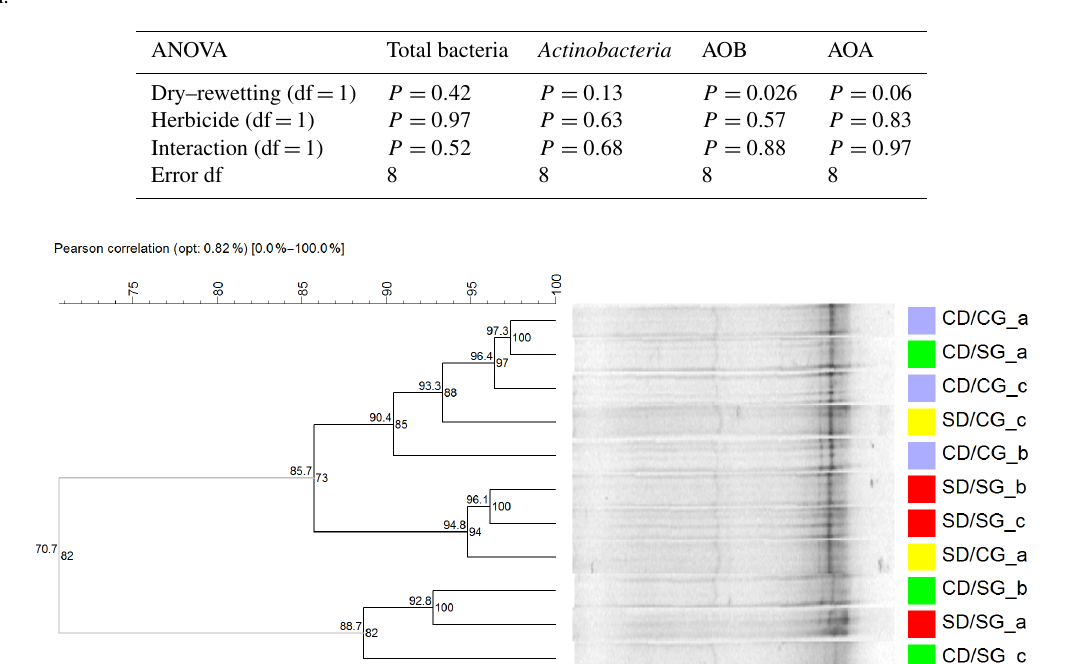
Figure 3. Cluster analysis of DGGE profiles of AOB. The dendrogram was obtained using Pearson–UPGMA analysis of densitometric profiles. Treatments are indicated in different colours. Lower-case letters indicate replicates within treatments. In each node, the left number indicates the similarity value ( r × 100), while the right number is the cophenetic correlation coefficient. Grey branches indicate clusters with 100% internal stability according to the jackknife method, defined at 80% similarity value. SD/SG: no dry–rewetting disturbance/no herbicide; SD/CG: no dry–rewetting disturbance/herbicide; CD/SG: dry–rewetting disturbance/no herbicide; CD/CG: dry–rewetting distur-